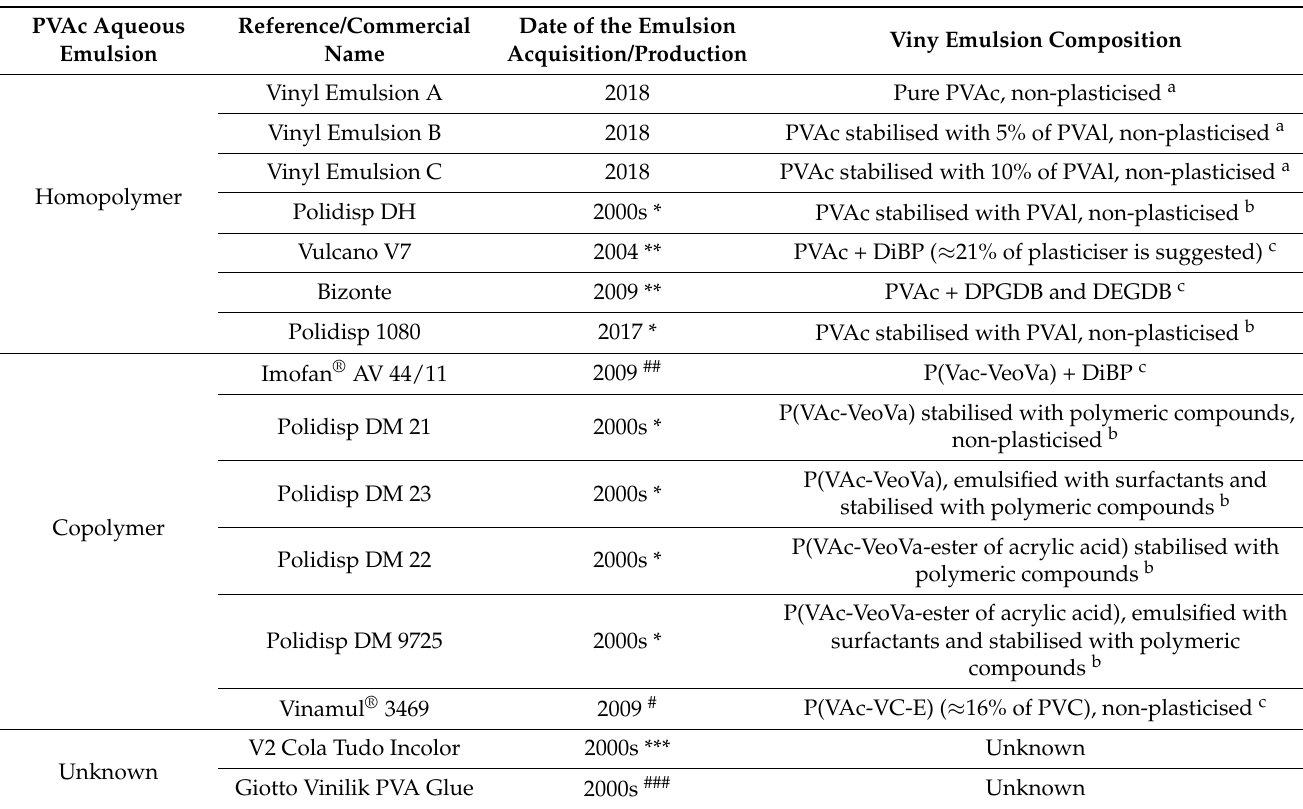
Table 1. Summary of the collected compositional information of the vinyl acetate-based emulsions before the current study. PVAc